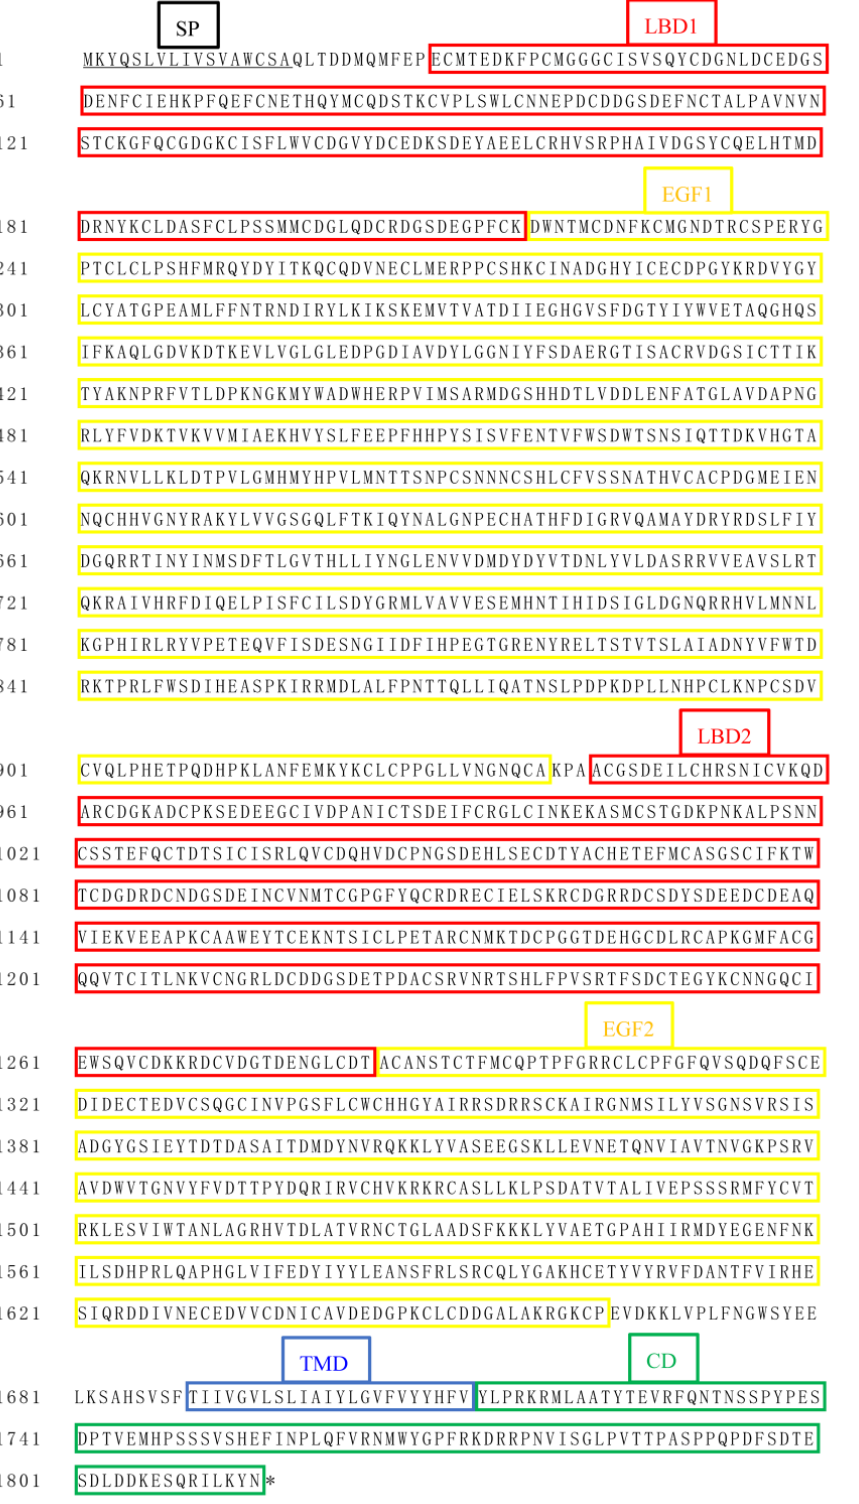
Figure 3. Amino acid sequence alignments of SfVgR. Signal peptides are underlined. The domains of LBD, EGF, TMD, and CD are shown in red, yellow, blue, and green boxes, respectively.